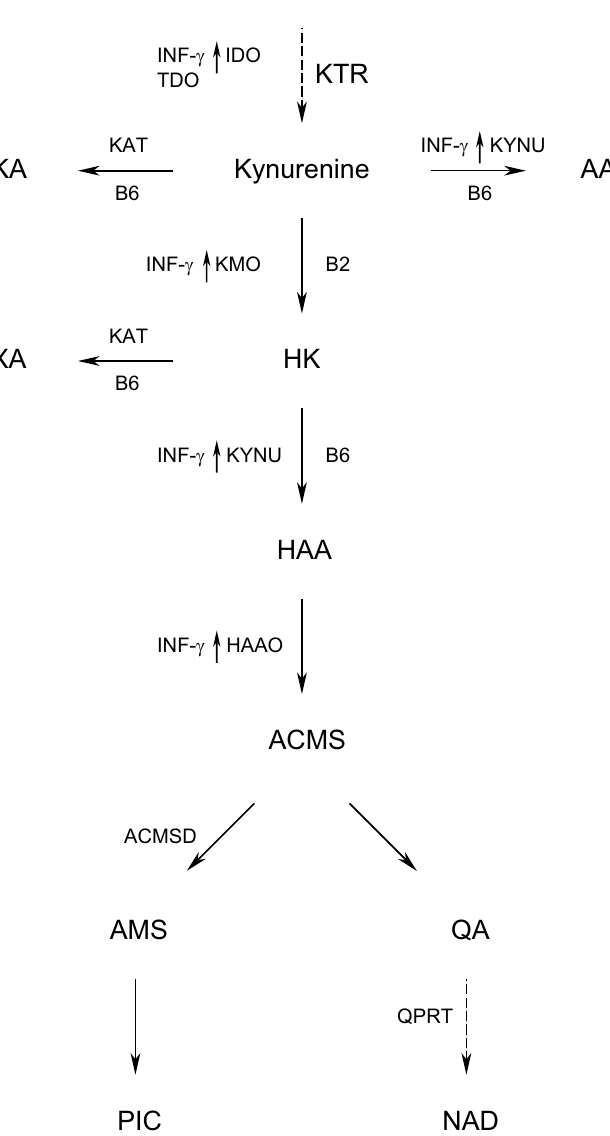
Figure 1. The kynurenine pathway of tryptophan metabolism, with enzymes and cofactors involved. Dashed arrow shafts indicate reactions with more than one step: Black arrows pointing up-wards indicate the enzymes which are stimulated by IFN-γ. AA: anthranilic acid; ACMS: α-amino-β-carboxymuconate-ε-semialdehyde; ACMSD: α-amino-β-carboxymuconate-ε-semialdehyde decarboxylase; AMS: α-aminomuconate-ε- semialdehyde; B2: vitamin B2 (flavin adenine dinucleotide); B6: vitamin B6 (pyridoxal 5 ′ -phosphate, PLP); HAA: 3-hydroxyanthranilic acid; HAAO: 3-Hydroxyanthranilate 3,4-dioxygenase; HK: 3-hydroxykynurenine; IDO: indoleamine (2,3)-dioxygenase; KA: kynurenic acid; KAT: kynurenine aminotransferase; KMO: kynurenine 3-monooxygenase; KYNU: kynureninase; NAD: nicotine adenine dinucleotide; TDO: tryptophan (2,3)-dioxygenase; PIC: picolinic acid; QA: quinolinic acid; QPRT: quinolinate phosphoribosyltransferase; XA: xanthurenic